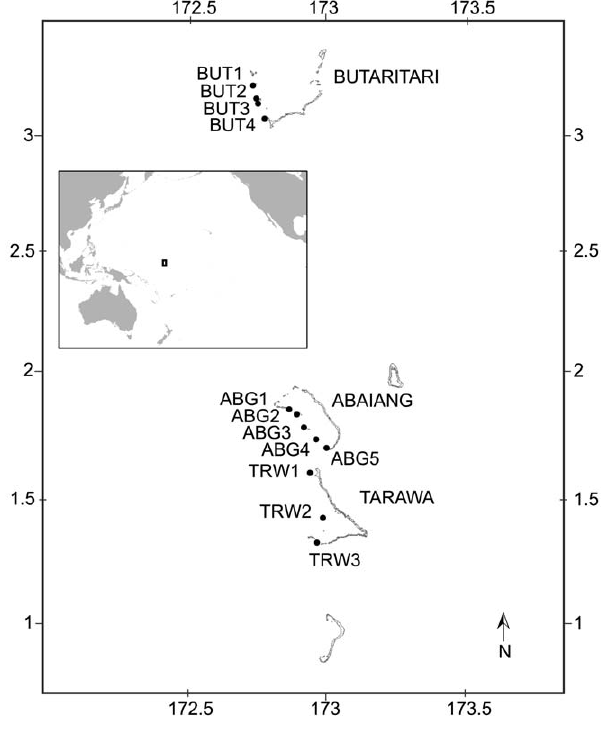
Figure 1. Map of sites studied. The box in the inset of the larger Pacific Ocean shows the location of the site map.